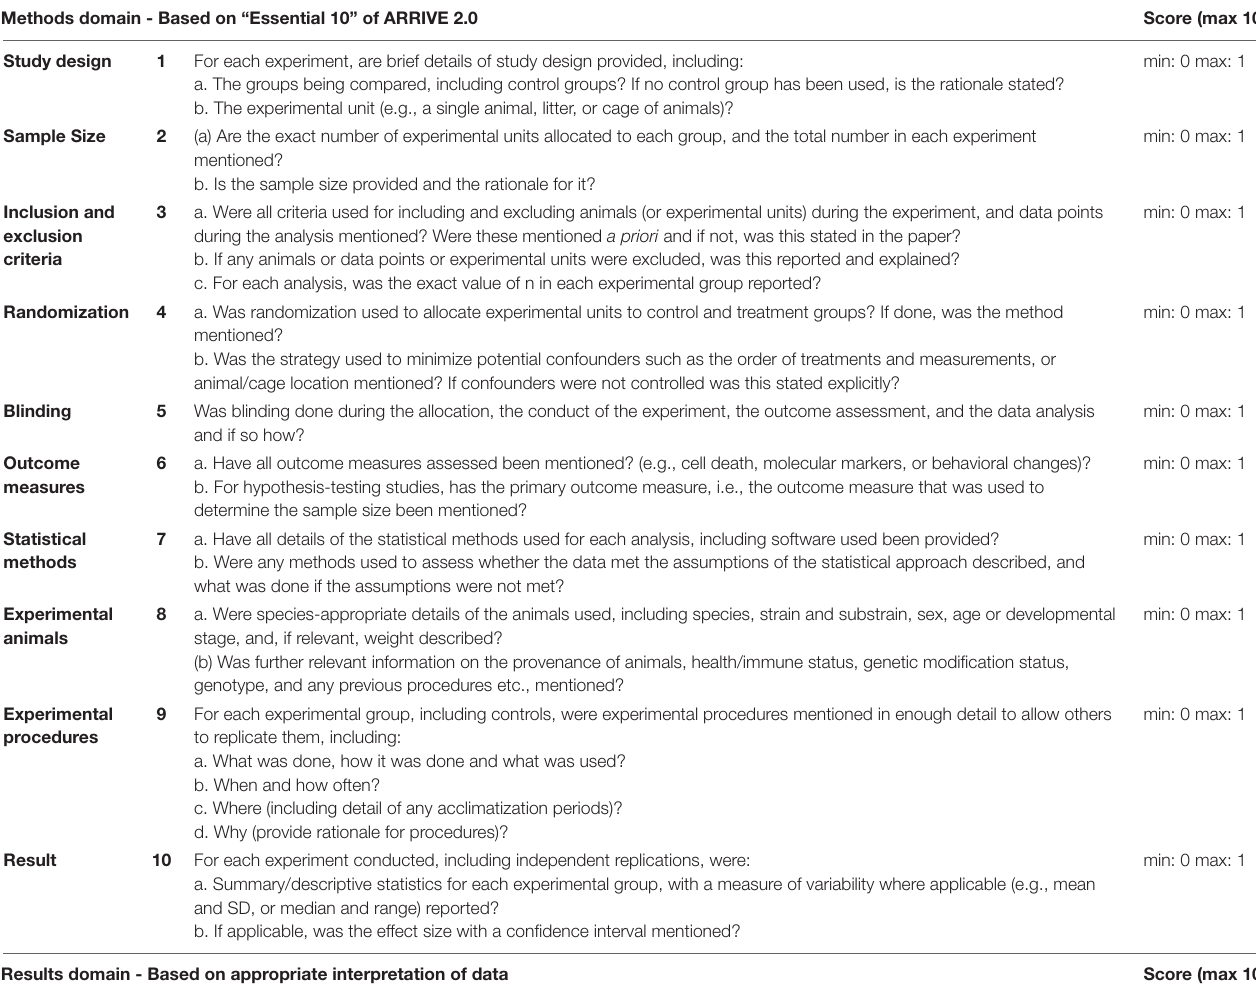
TABLE 2 | “Scorecard” checklist for the in vivo protocols. Methods domain - Based on “Essential 10” of ARRIVE